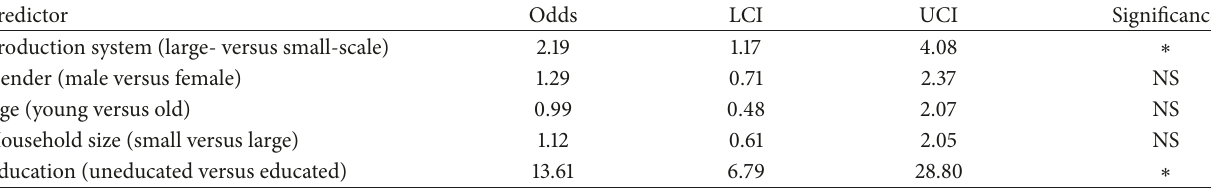
Table 6: Odds ratios estimates and lower (LCI) and upper confidence interval (UCI) of farmers considering milk safety to be important.